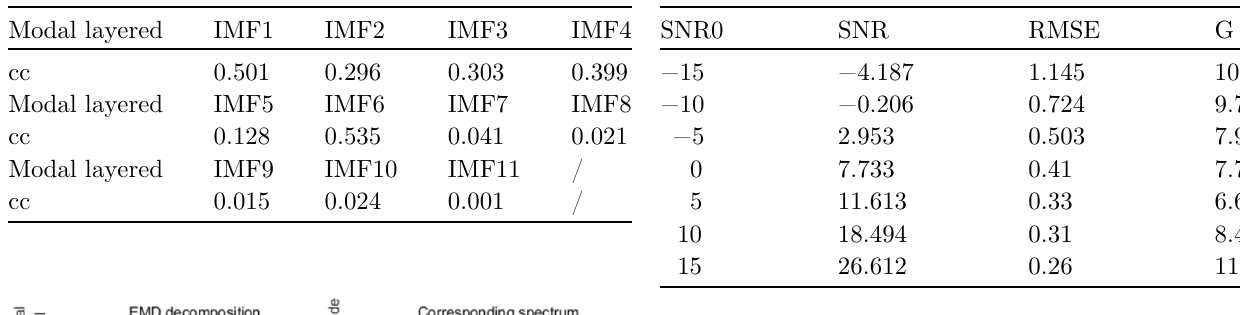
Table 1. Correlation coef fi cient between intrinsic mode and original signal.